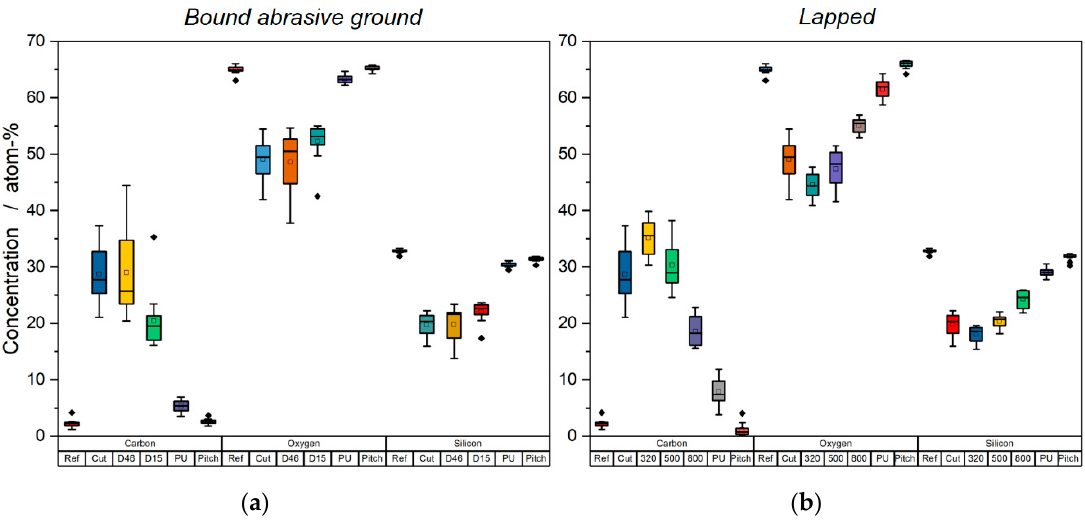
Figure 2. Carbon, oxygen and silicon concentration after each manufacturing step for bound abrasive ground ( a ) and lapped ( b ) samples. For explanation of the particular sample designations given in the x-axis, see Figure 1.